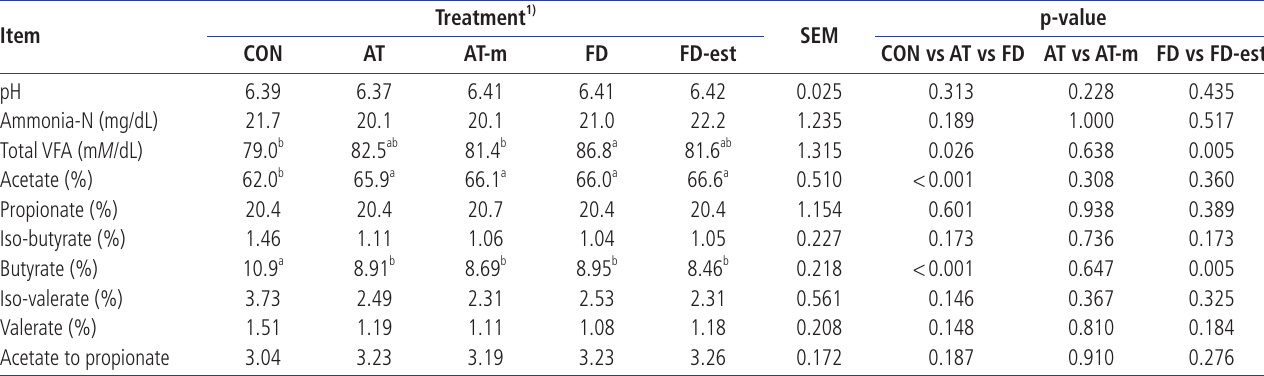
Table 6. Effects of rye silages treated with wild and mutated inoculants on rumen fermentation indices incubated for 96 h